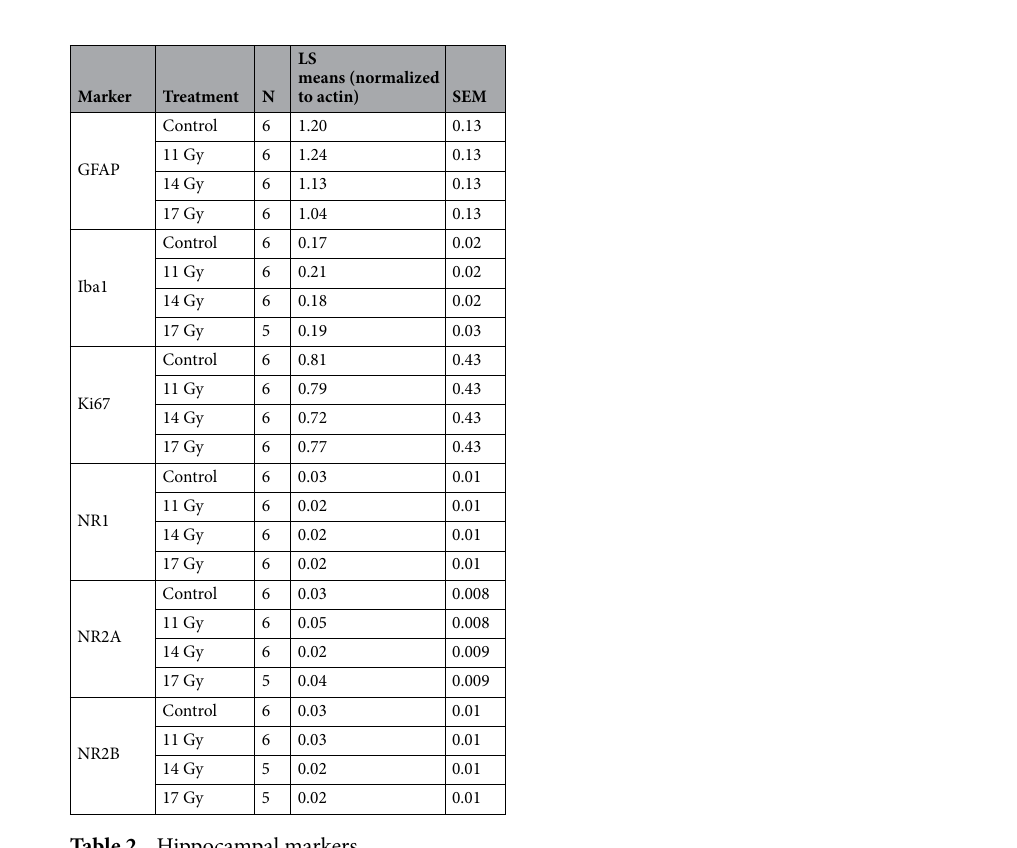
Table 2. Hippocampal